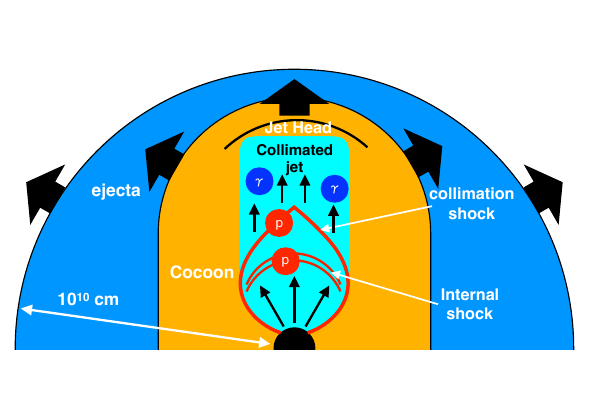
Figure 2. Schematic picture of the choked jet system. This figure is reproduced from [20].